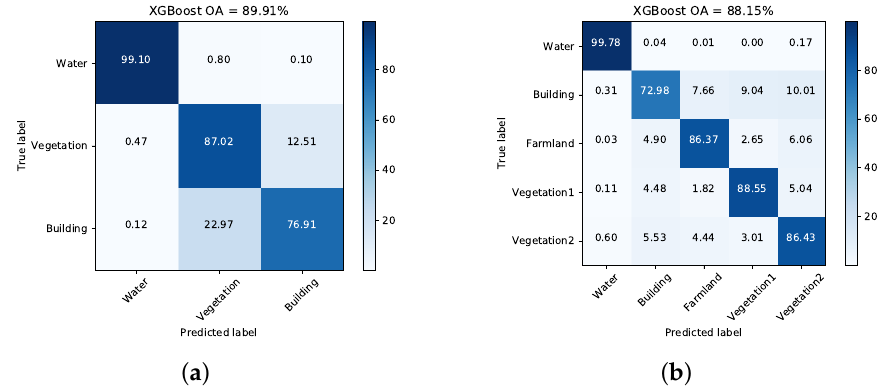
Figure 9. Confusion matrices acquired via XGBoost on both data sets. ( a ) Data set A. ( b ) Data set